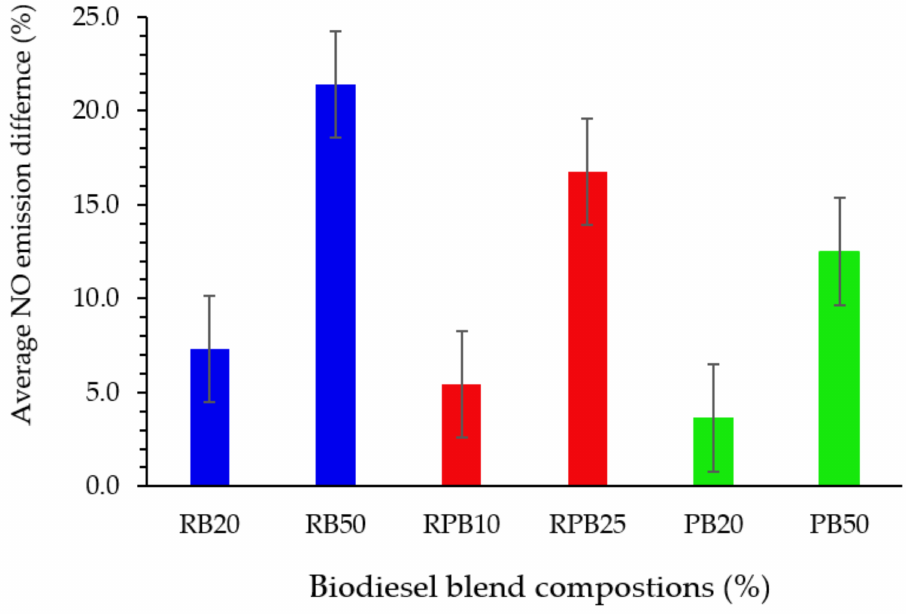
Figure 10. Average NO emission difference in comparison to diesel